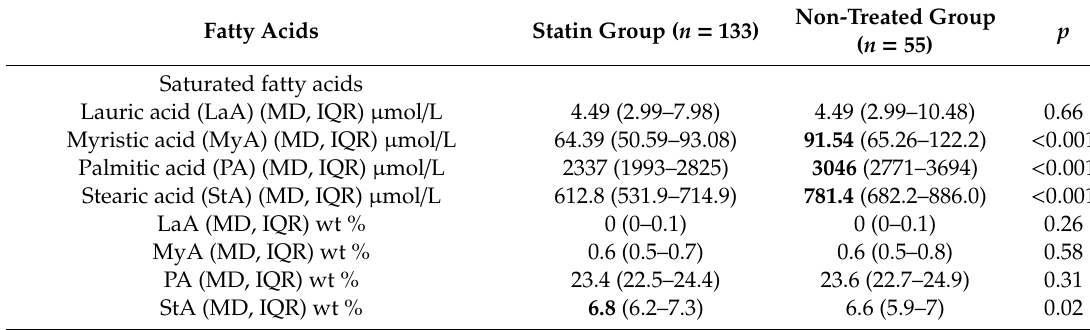
Table 2. Di ff erences in fatty acids between statin and non-treated groups. Fatty